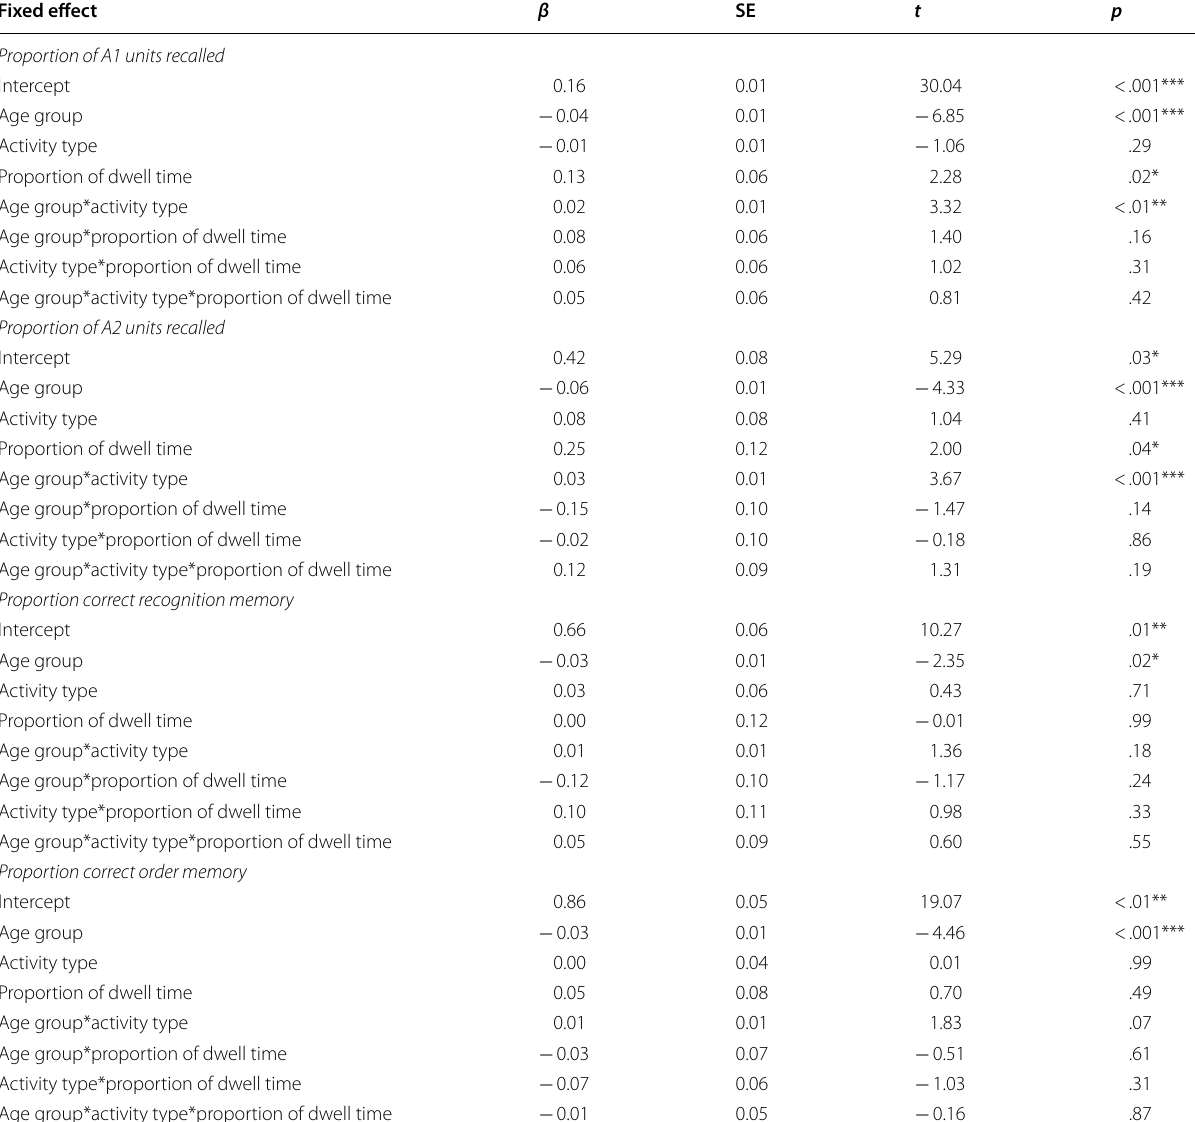
Table 4 Table of fixed effects for recognition, order, and free recall memory performance as a function of age group, activity type, and proportion of dwell time in the goal-relevant